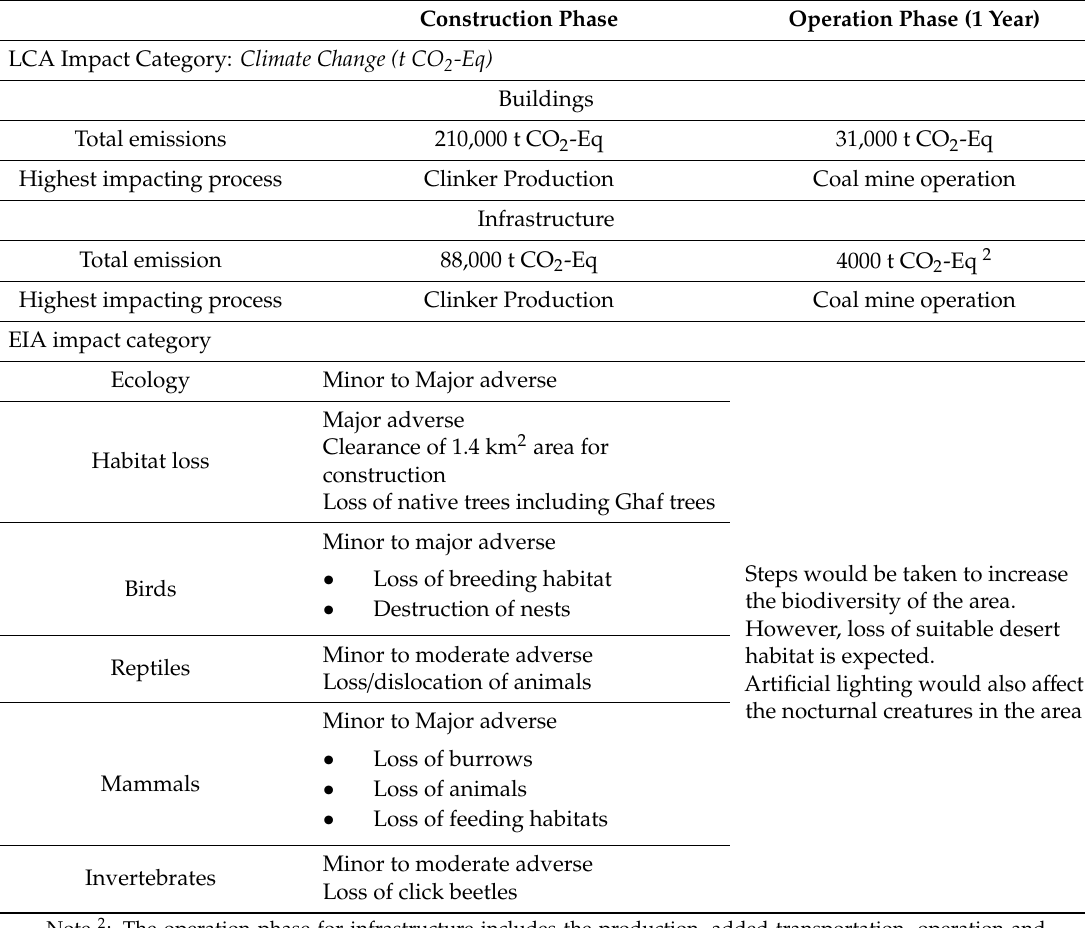
Table 5. O ff -site and on-site impacts of the development phase (DP) on ecosystem.